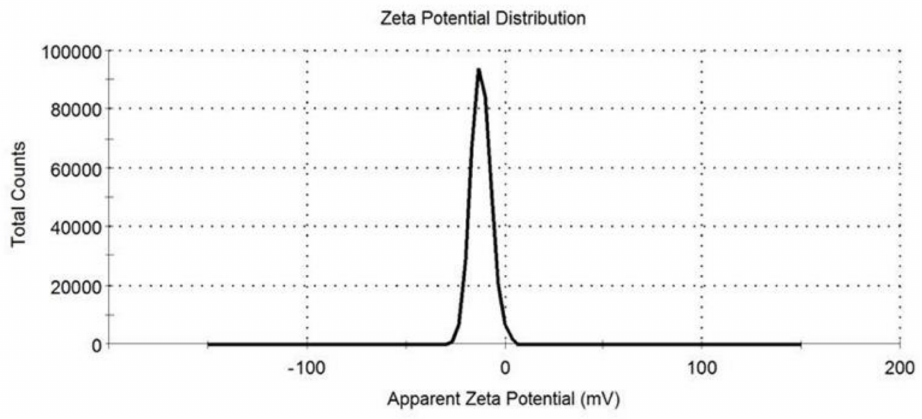
Figure 9. The zeta potential of biosynthesized palladium nanoparticles.